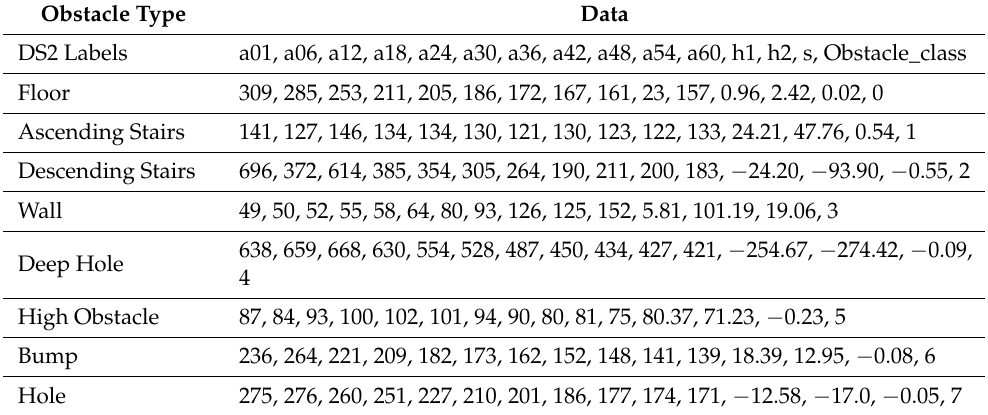
Table 6. Dataset 2 (D2) Sample.